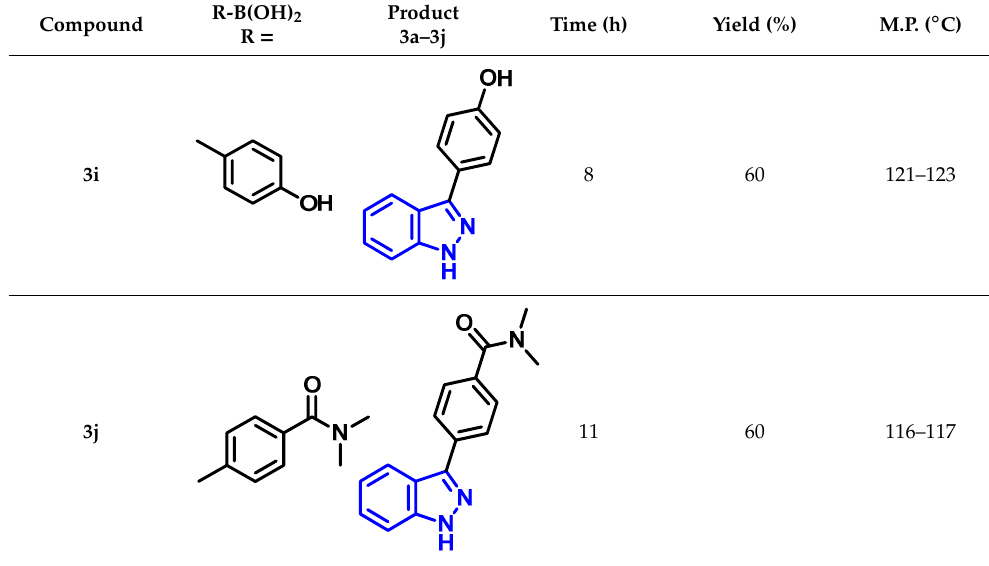
Table 2. Details of the series of compounds 5a–5j.